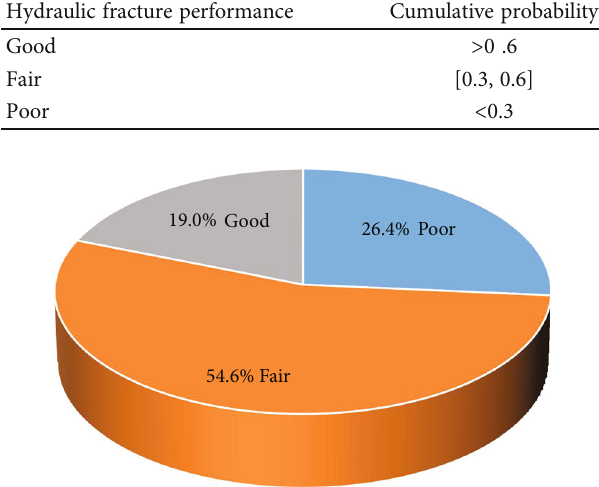
Figure 8: Evaluation results of hydraulic fracture performance in the block of the eastern Sulige